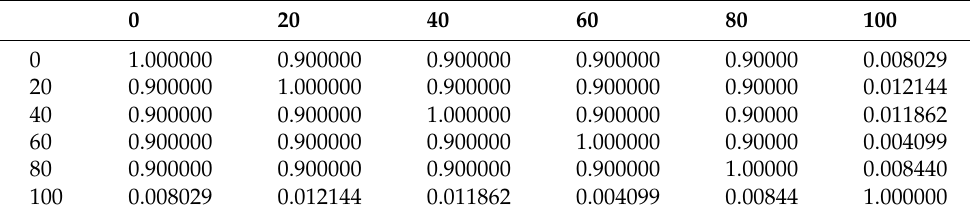
Table 4. Multiple Comparison Test (Tukey’s method) performed on clogging level groups from Airflow CH1 signals.